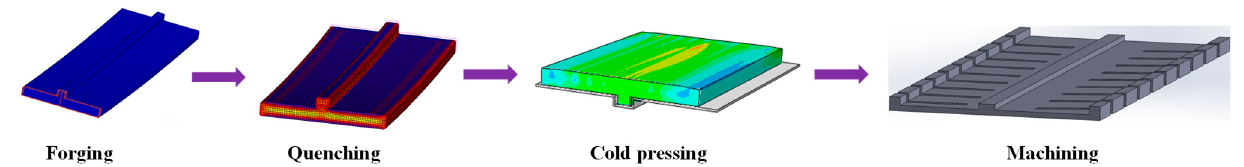
Figure 1. The preparation process of the T-type rib. Figure 1 . The preparation process of the T-type rib .